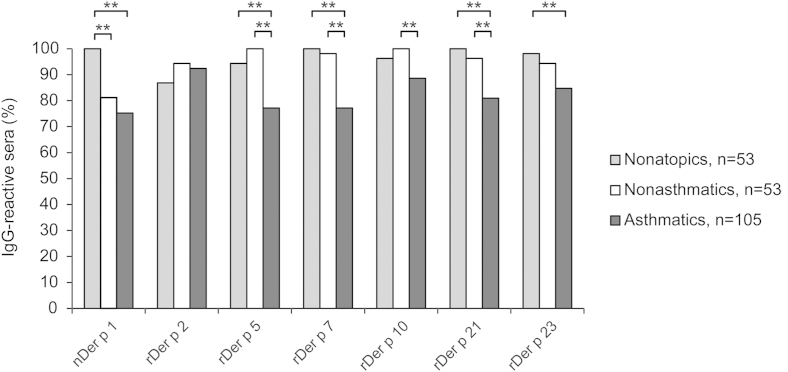
Frequencies of IgG reactivities to individual HDM allergens in asthmatic and nonasthmatic children with HDM allergy, as well as nonatopic subjects. IgG-binding frequencies (y-axis: percentages) to the allergens (x-axis) are shown for nonatopic (light gray), nonasthmatic (white bars), and asthmatic (dark gray bars) patients with HDM allergy. Statistically significant differences between the groups are indicated. **P < .01.